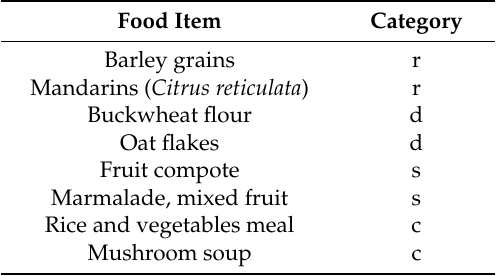
Table 3. Correctly classified instances by the StandFood classification